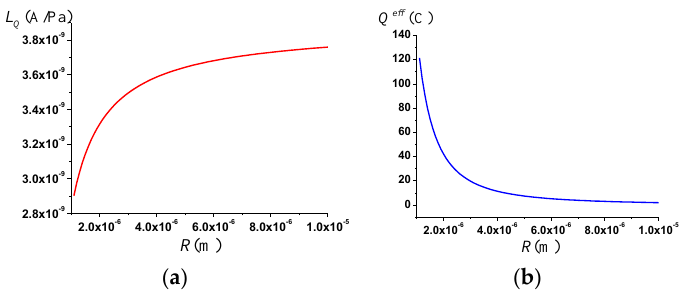
Figure 7. Effect of pore size (time-harmonic case): ( a ) streaming current coupling coefficient; ( b ) effective net residual charge density.